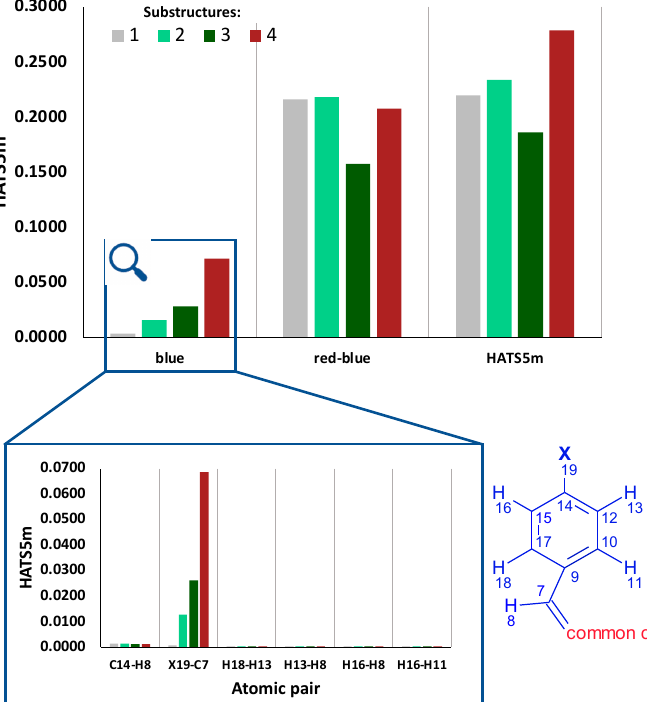
Figure 8. The contribution of intra- and inter-fragments effects in the HATS5m value. In magnification: the impact of atomic pairs in blue (R4) fragment on HATS5m value. The letter “X” represents the halogen atoms F, Cl, and Br in substructures 2, 3, and 4, respectively.